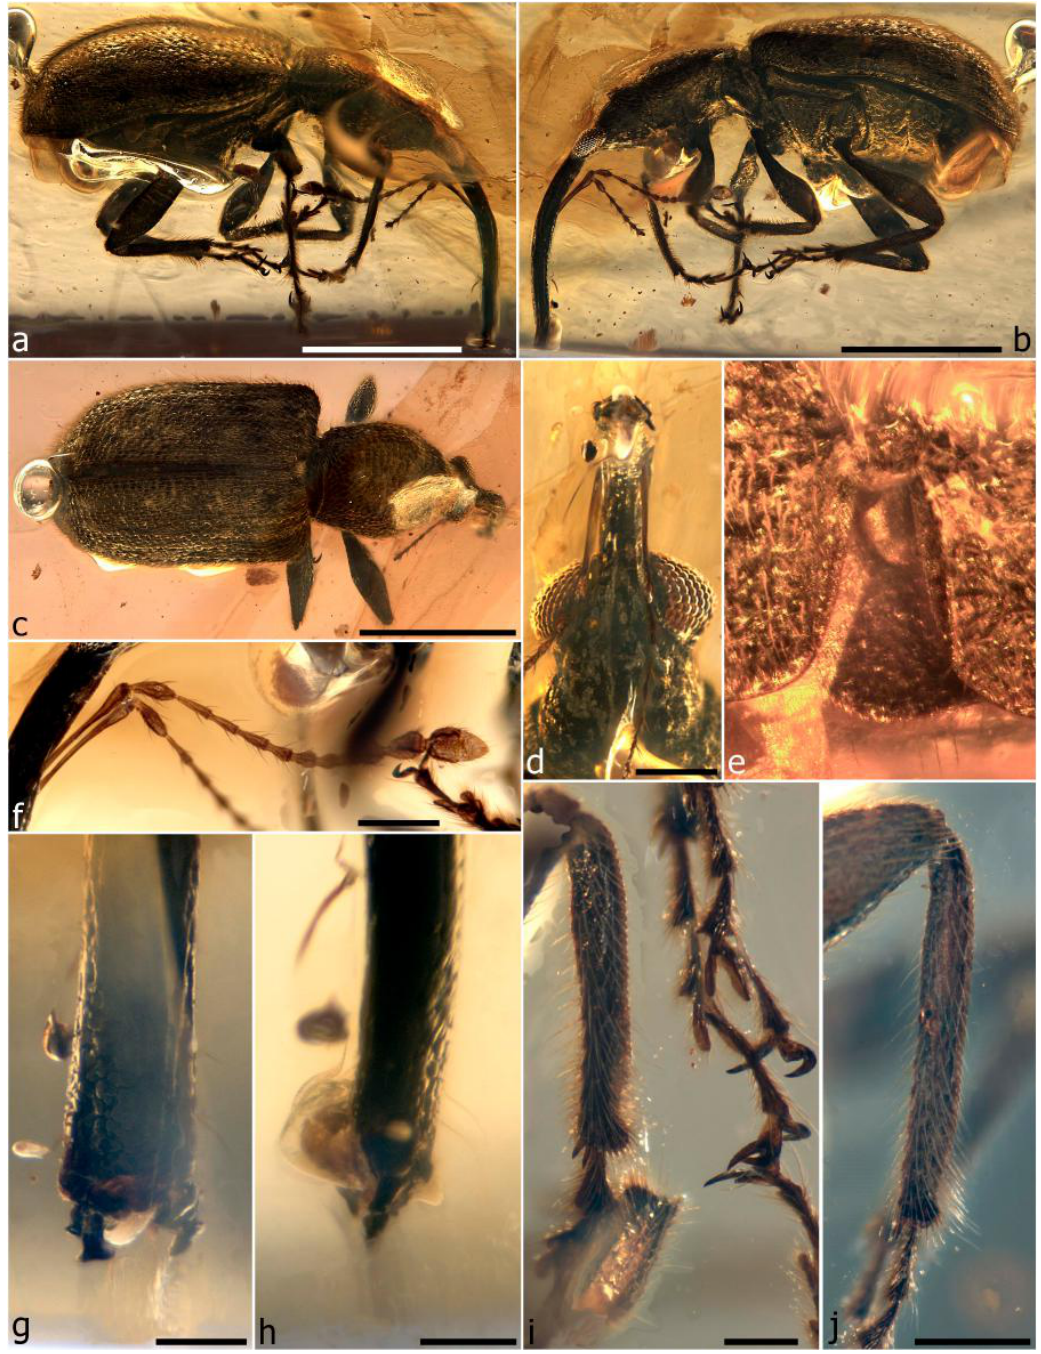
Figure 77. Habropezus kimpulleni sp. n., holotype. Habitus, right lateral ( a ); habitus, left lateral ( b ); habitus, dorsal ( c ); head, ventral ( d ); elytra and apical tergite, apical ( e ); antennae ( f ); rostrum apex and mandibles, dorsolateral ( g ); same, right lateral ( h ); tarsi and left mesotibia ( i ); left metatibia ( j ). Scale bars: 1.0 mm ( a – c ); 0.2 mm (d,f,j); 0.1 mm (g–i).